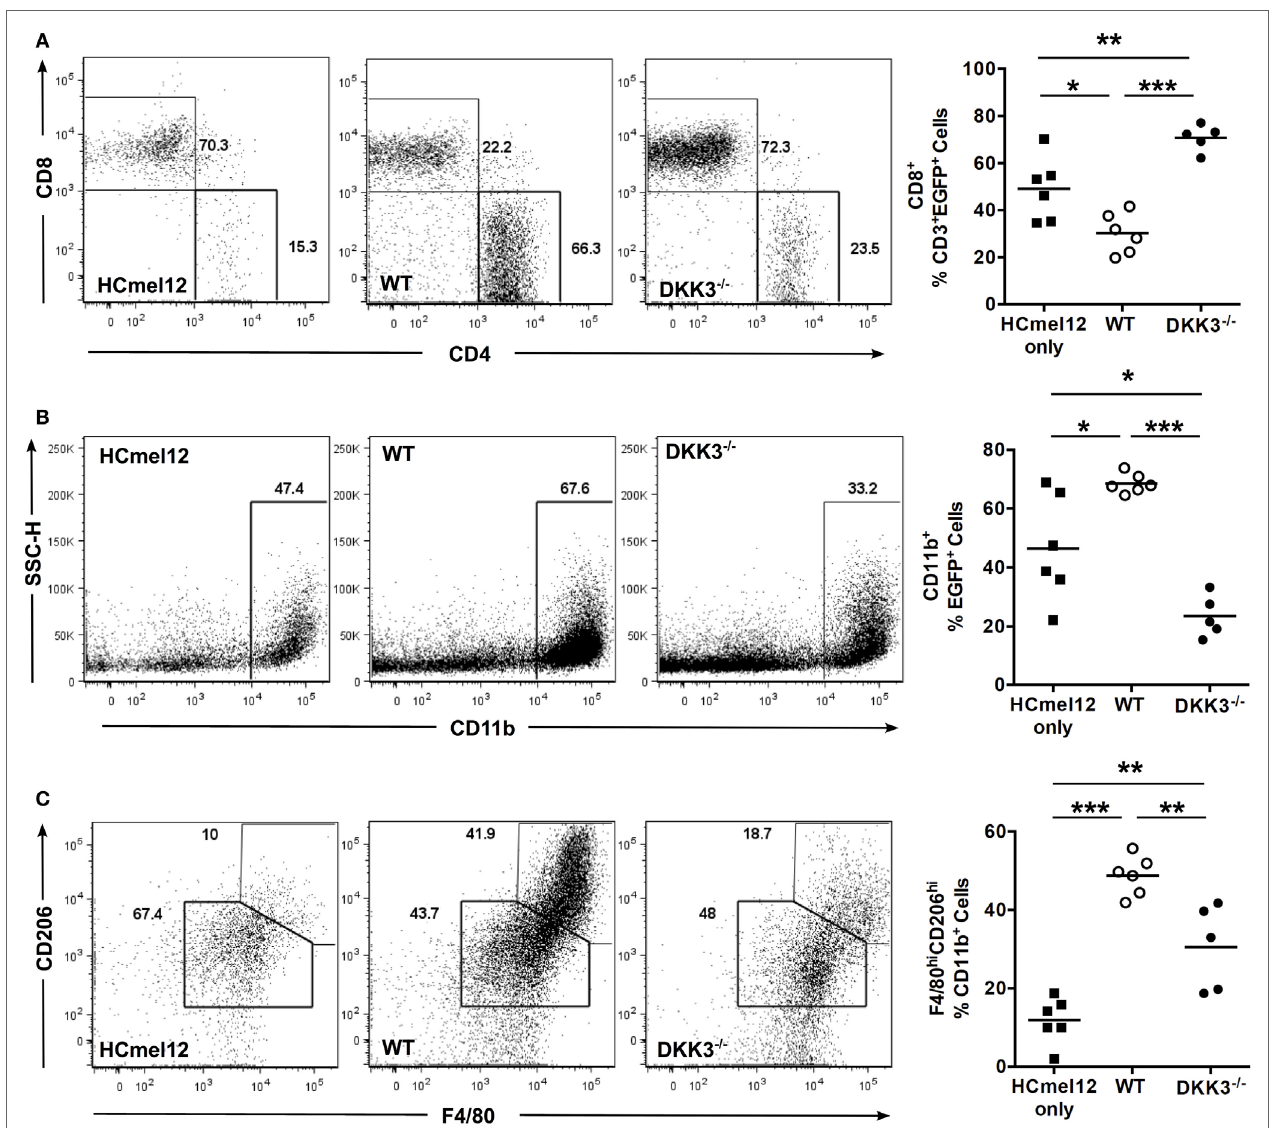
FigUre 2 | DKK3 expression by Mscs contributes to modulating the composition of tumor-infiltrating immune cells . (a) 4 × 10 5 HCmel12 melanoma tumor cells only ( ◾ , n = 6) or with equal number of MSCs ( ⚬ , wild-type, n = 6; ⚫ , DKK3 − / − , n = 5) were inoculated subcutaneously into EGFP + mice with B6 background. Fourteen days later, tumor nodules were isolated and the infiltrating EGFP + cells were analyzed by flow cytometry. A significant reduction in the percentage of infiltrating CD8 + T cells was detected in tumors with wild-type MSCs in comparison with tumors without any MSC ( p = 0.0142). In contrast, an increased infiltration of CD8 + T cells was observed for tumors with DKK3 − / − MSCs in comparison with tumors with wild-type MSCs ( p < 0.0001) or with tumors without any MSC ( p = 0.0076). (B) A higher percentage of CD11b + cells was found in wild-type MSCs-associated tumors in comparison with the tumor only group ( p = 0.0136), whereas tumor-infiltrating CD11b + cells were significantly decreased in tumors containing DKK3 − / − MSCs in comparison with tumors containing wild-type MSCs ( p < 0.0001) and in comparison with HCmel12 tumors without any MSC ( p = 0.0141). (c) M2-type macrophages were defined as F4/80 hi CD206 hi cells out of CD11b + cell population. A higher percentage of M2-type macrophages was found in tumors with wild-type MSCs in comparison to tumors containing DKK3 − / − MSCS ( p = 0.0033) and with tumors without any MSC ( p < 0.0001). The level of M2-type macrophages remained higher in tumors containing DKK3 − / − MSCs in comparison with tumors without any MSC ( p = 0.0025). Two independent experiments were performed. ANOVA followed by the Holm-Šídák approach to multiple comparisons was applied for the